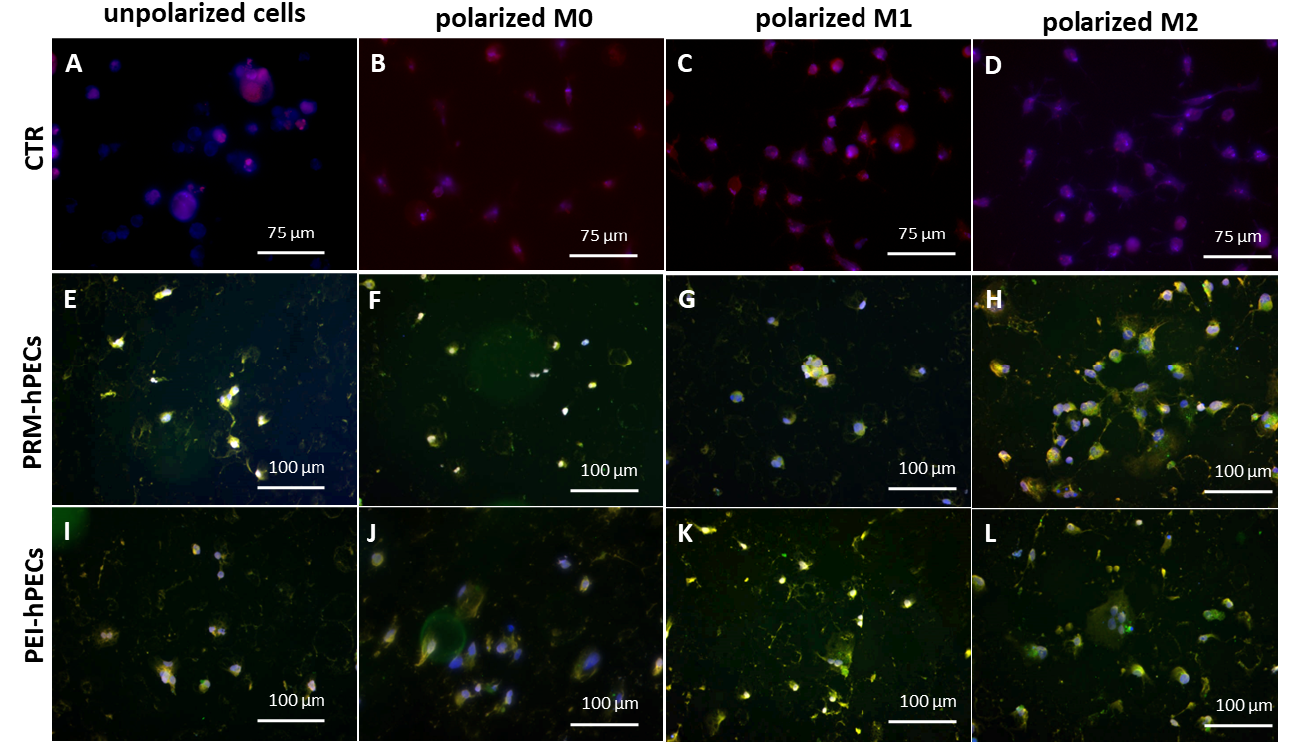
Figure 6. Fluorescence merge images of unpolarized THP-1 cells and polarized M0, M1, and M2 THP-1 cells treated for 48 h with FITC-PRM ( E – H ) or FITC-PEI hPEC ( I – L ). Non-treated cells were used as control (( A – D ) CTR). In red, NF- κ B factors; in green, hPECs; and in blue, nuclei. Scale bars: 75 µ m and 100 µ m. Representative images of three independent experiments are